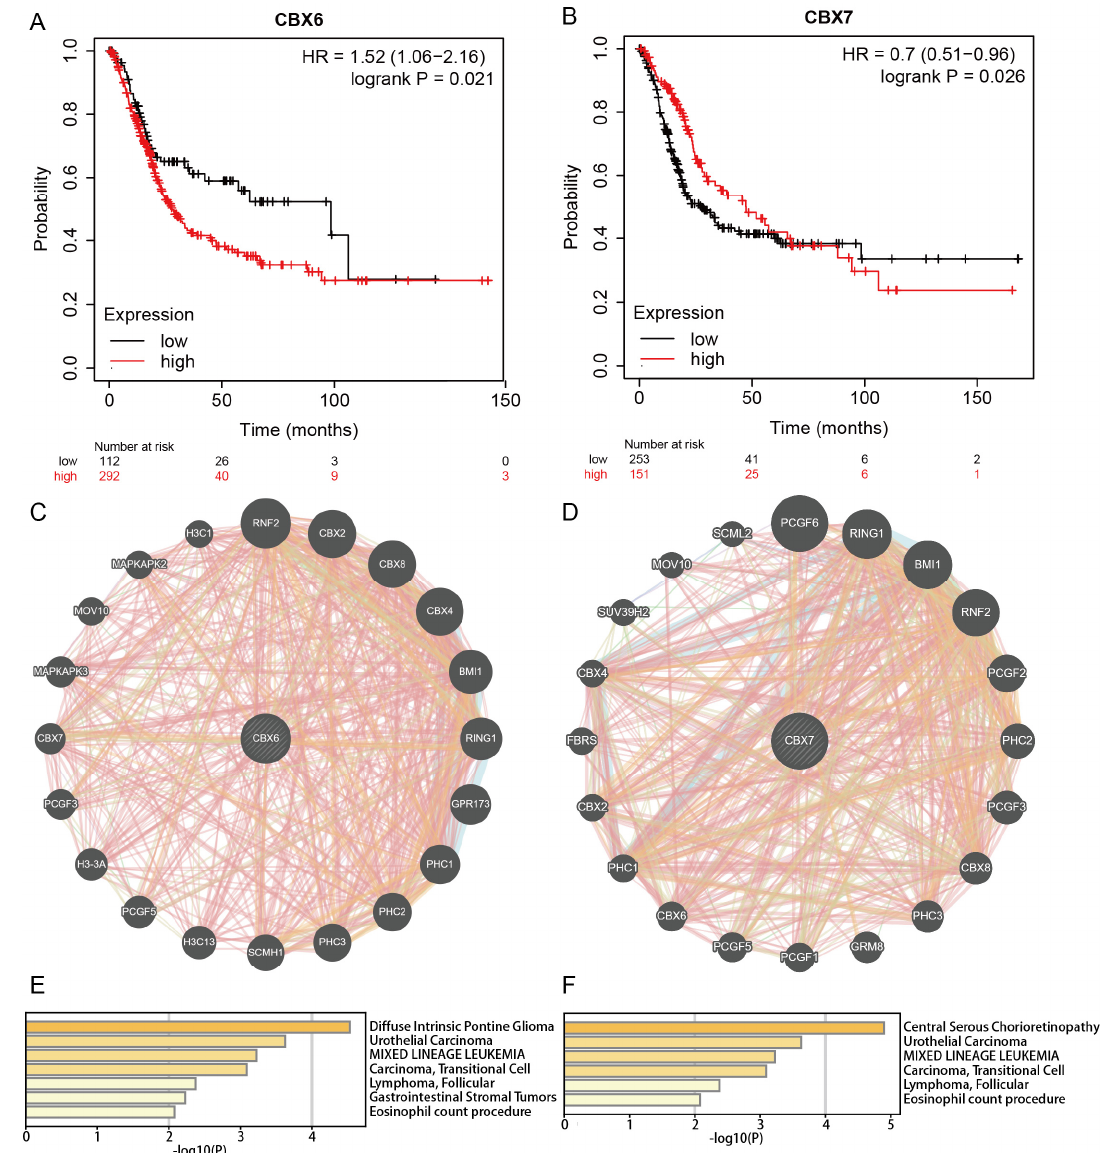
Figure 5. Analysis of the potential roles and pathways of CBX6, CBX7, and their coexpressed neighbors in BLCA. ( A , B ) Validation of the predictive value of CBX6 and CBX7 using the Kaplan‒Meier ploer database. ( C , D ) CBX6, CBX7, and their coexpressed neighbors from GeneMANIA. ( E , F ) Analysis of the potential roles and pathways of CBX6 and CBX7 in Metascape.